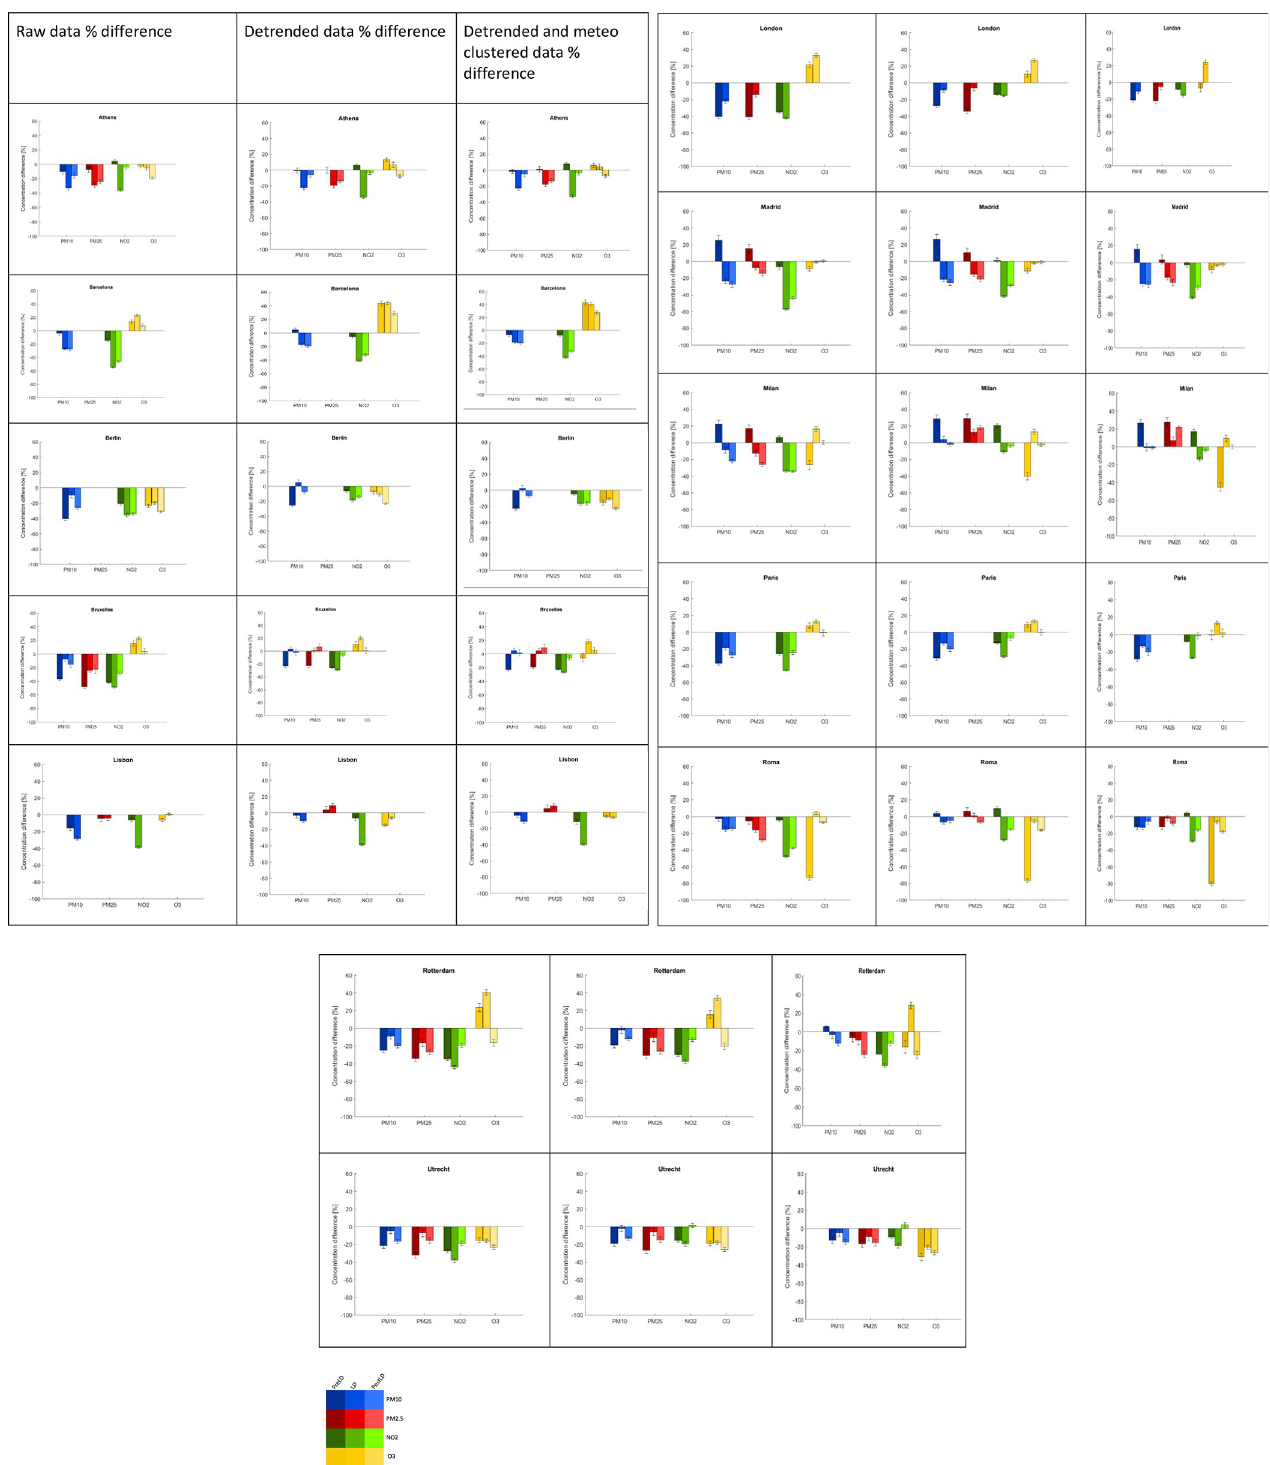
Fig 3. Results. Percentage changes of PM 10 (blue), PM 2.5 (red), NO 2 (green), and O 3 (yellow) of daily mean concentrations during preLD (dark bars), LD (medium bars), and postLD (light bars) periods in 12 European cities. Column 1: raw data, no processing applied; column 2: detrending only applied; column 3: detrending and meteorological clustering